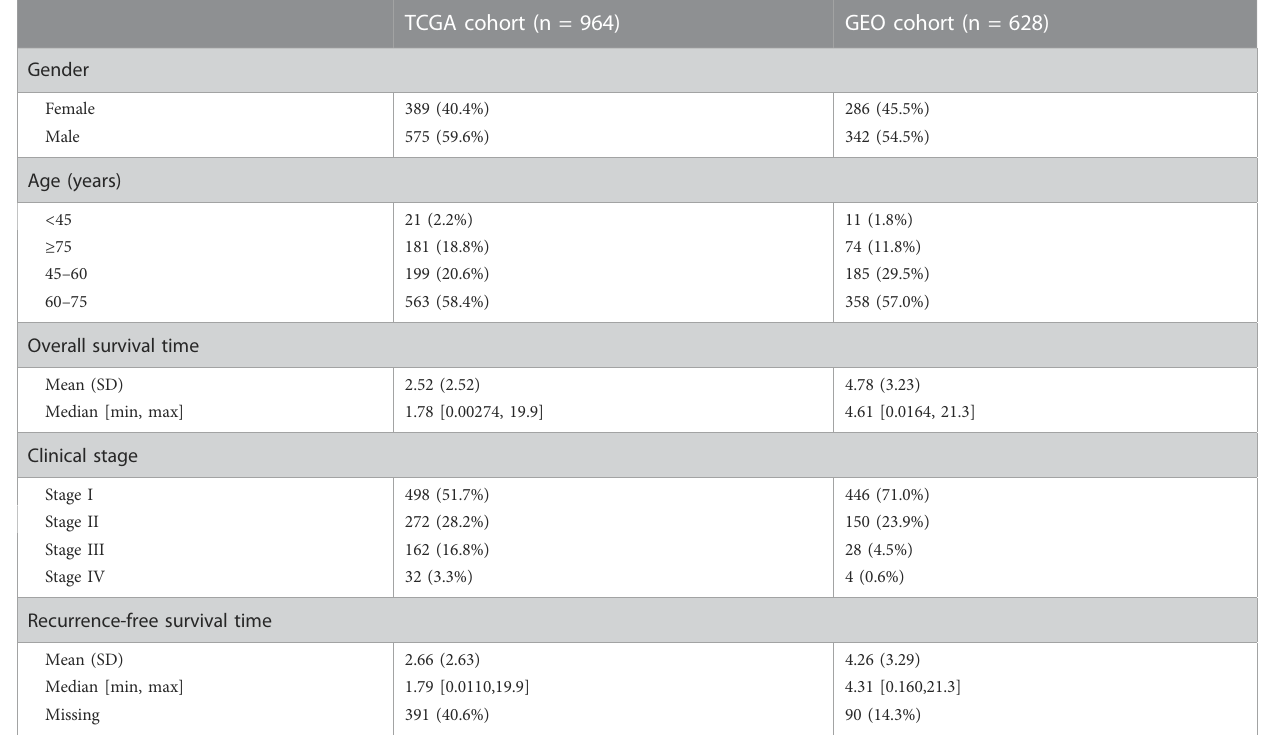
TABLE 1 The clinical pathological information of TGCA and GEO